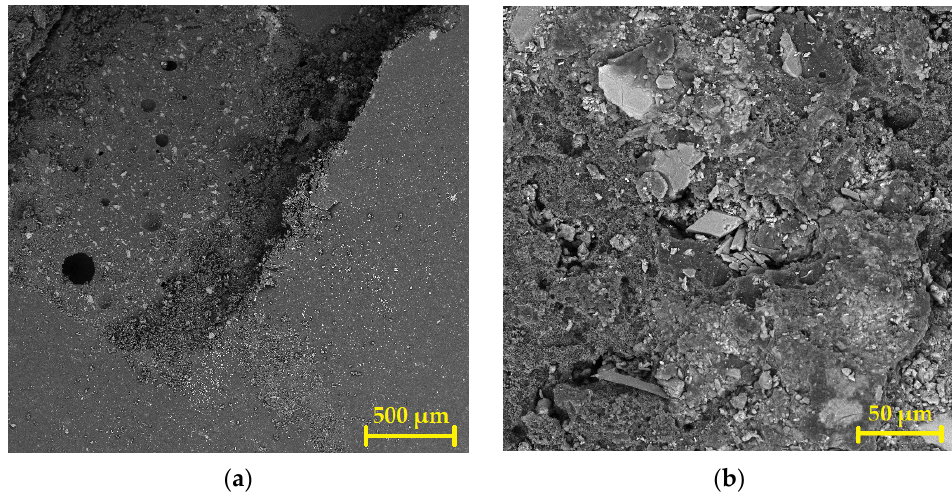
Figure 12. SEM photomicrographs of the coating with rounded particles (NBR-REF): ( a ) reference coating not exposed to the aggressive environment—50× magnification; ( b ) NBR-REF after exposure to CH 2 O 2 for 120 days—500× magnification.